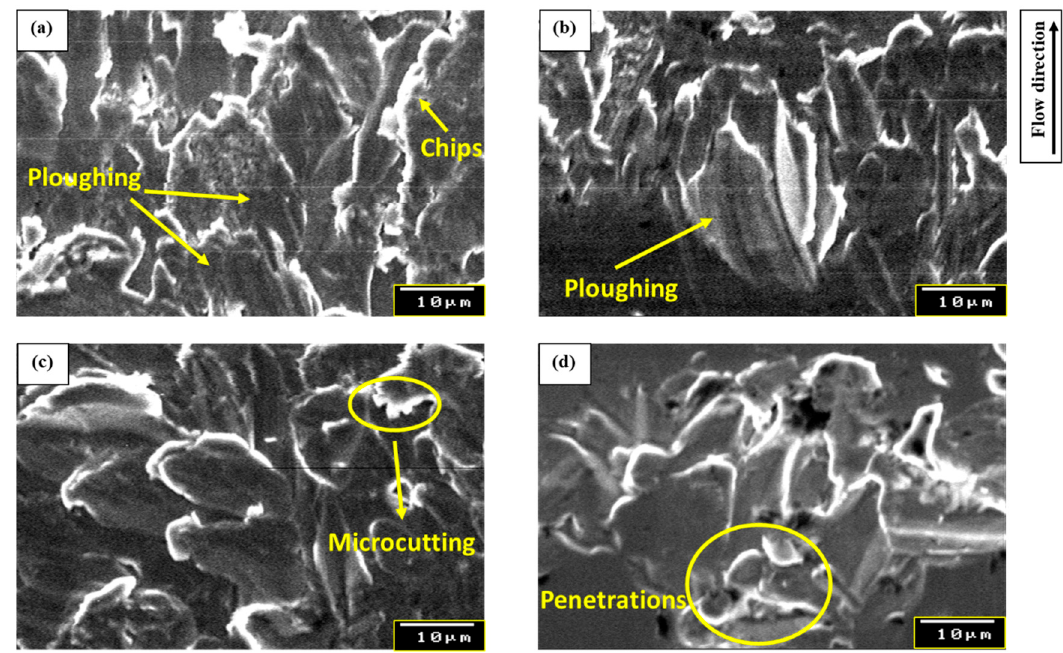
Figure 11. SEM morphologies of the SLMed Ti-6Al-4V alloy due to slurry erosion in pure water and seawater at impact angles of ( a ) 30°, ( b ) 45°, ( c ) 60°, and ( d ) 90°.